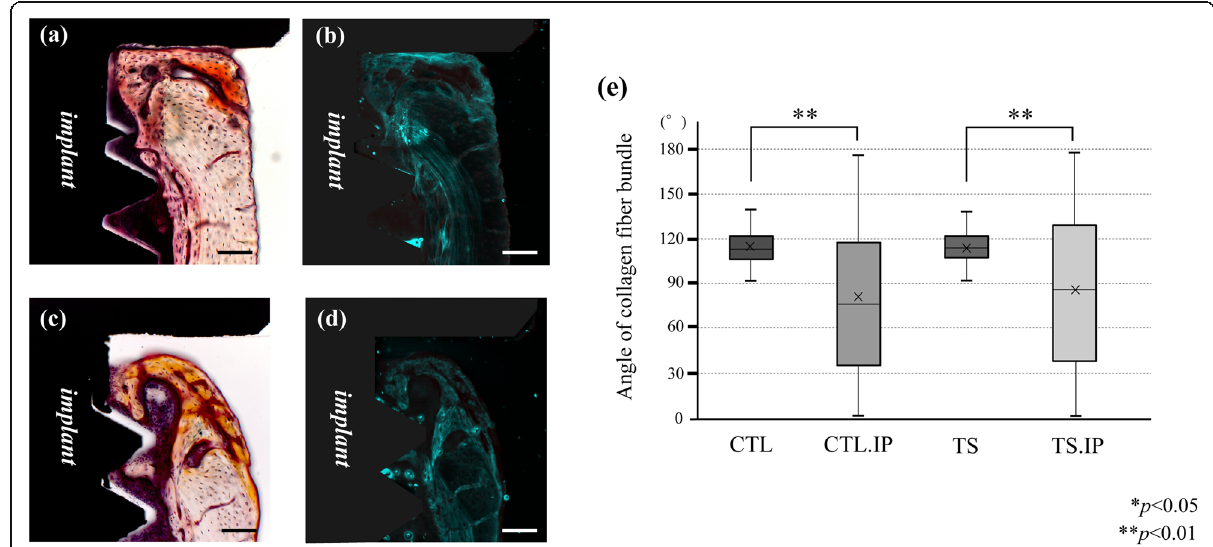
Fig. 9 SHG imaging in the peri-implant area. a Optical microscope image of CTL.IP. b SHG imaging of CTL.IP. c Optical microscope image of the TS.IP. d SHG imaging of the TS.IP. a – d 100× magnification. Bar: 100 μ m. e Box-and-whisker plot of the angle of the collagen fiber bundle with respect to the Y